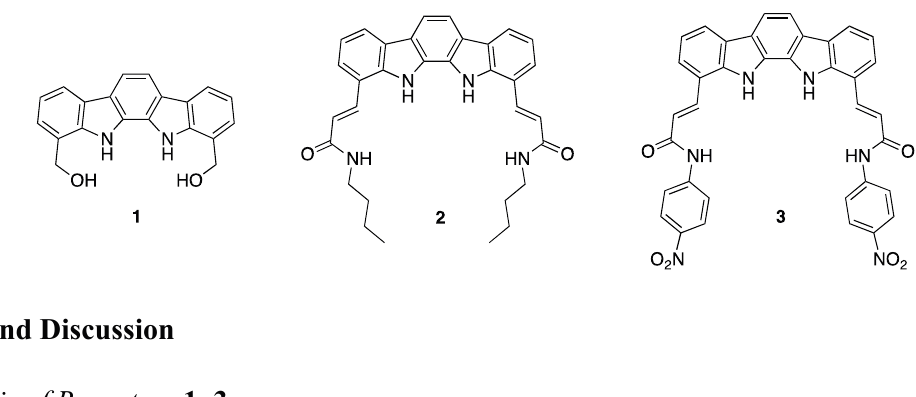
Figure 1. Structures of indolocarbazole-based